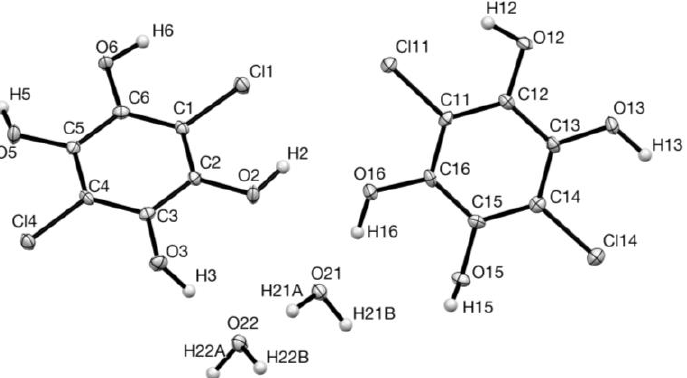
Figure 1. Structure of the four independent molecules showing numbering (thermal ellipsoids at 50% level).